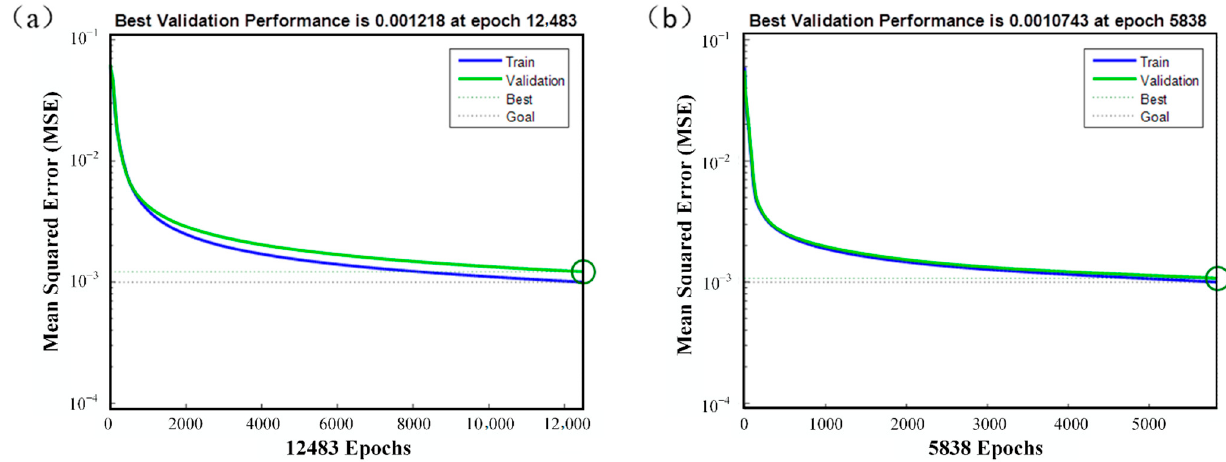
Figure 5. MSE downtrend comparison before and after GA optimization: ( a ) before optimization; ( b ) after optimization.